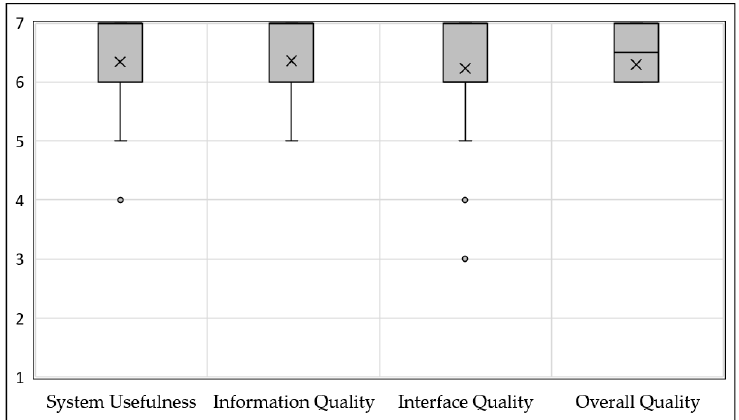
Figure 3. CSUQ box-whisker plot.